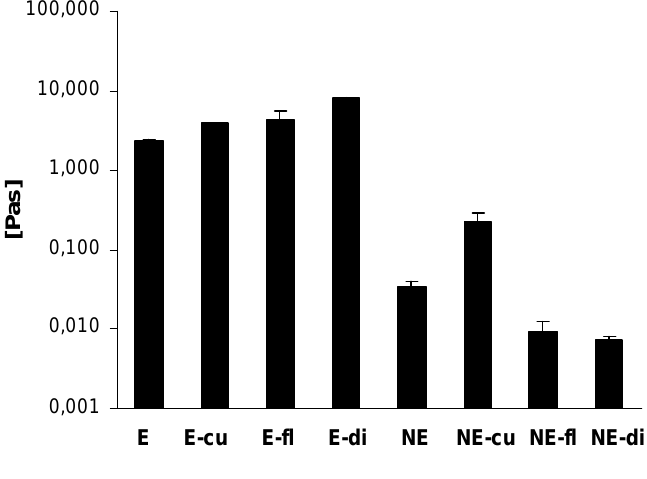
Figure 7. Comparison of the apparent viscosity of macroemulsions (E) and corresponding nanoemulsions (NE) with and without incorporated drug at a shear rate of 15 s −1 . The effect of the incorporated drugs curcumin (cu), flufenamic acid (fl) and diclofenac acid (di) is demonstrated. Values represent the mean of three formulations (n = 3) and are given ±